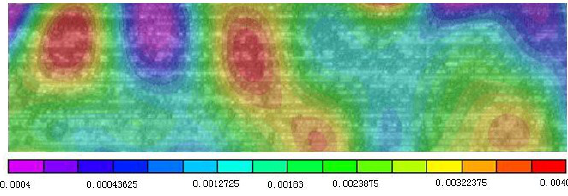
Figure 22: Strain distribution(Force=20N)